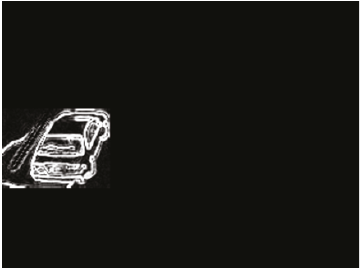
Figure 6: The result of subtracting BI edge from MI edge MBR .